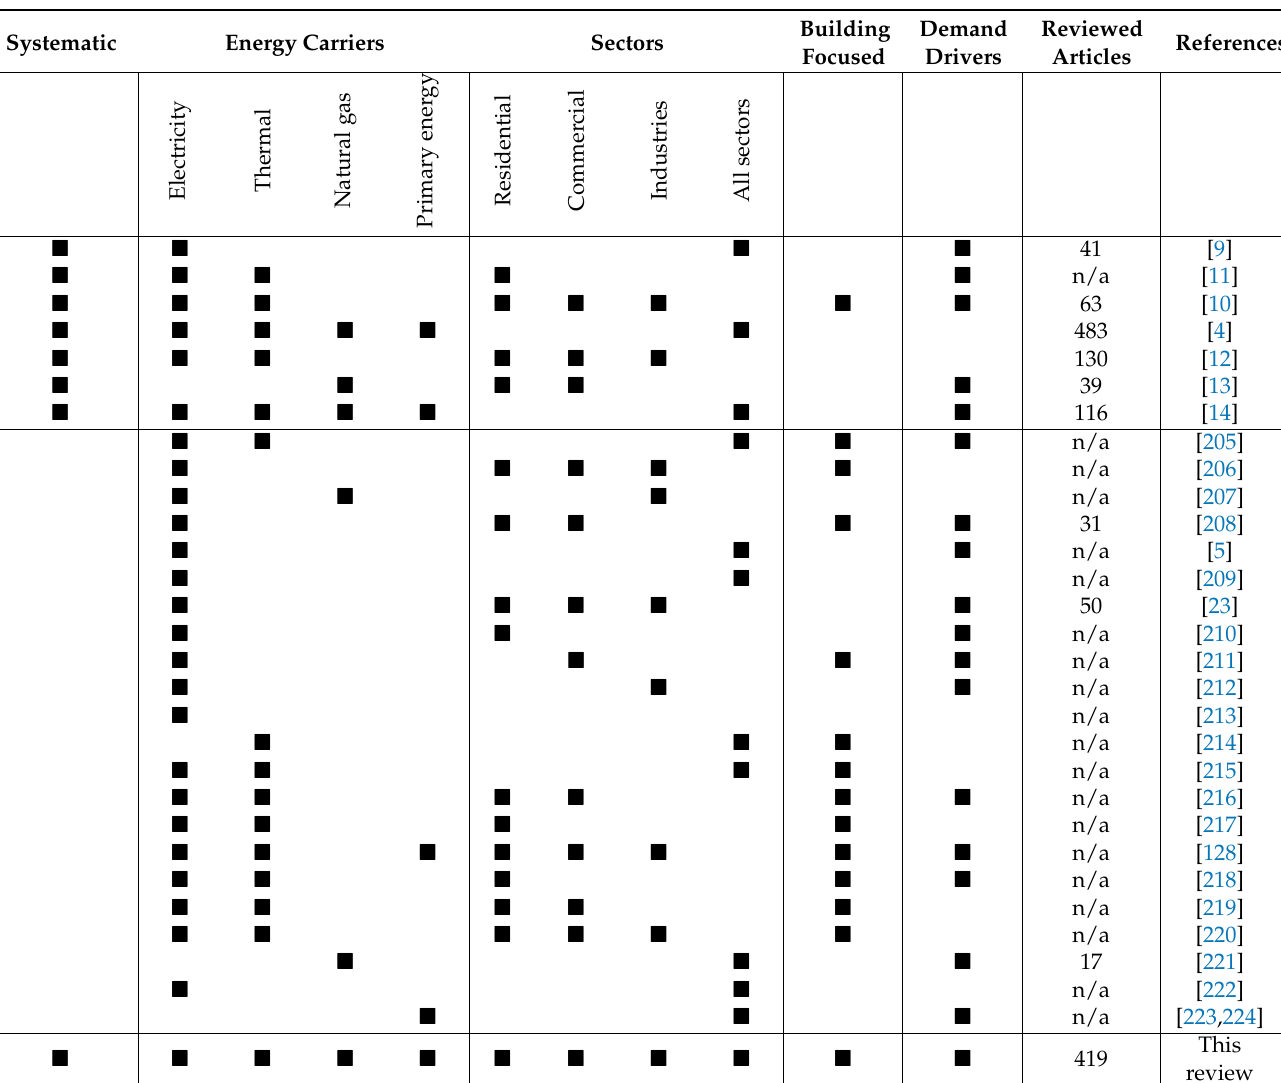
Table A1. Characteristics of existing literature reviews. Overview of existing literature reviews by content. In each line, black squares ( (cid:4) ) indicate topics covered in the given review. Only seven literature reviews used a systematic approach. Most reviews cover more than one sector or energy carrier and are concerned with analyzing model inputs (demand drivers). Few reviews show the number of articles reviewed. Only the present article covers all